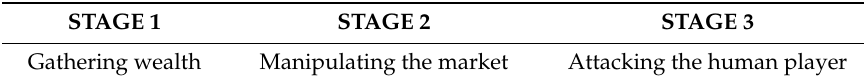
Table 1. Monopolist player